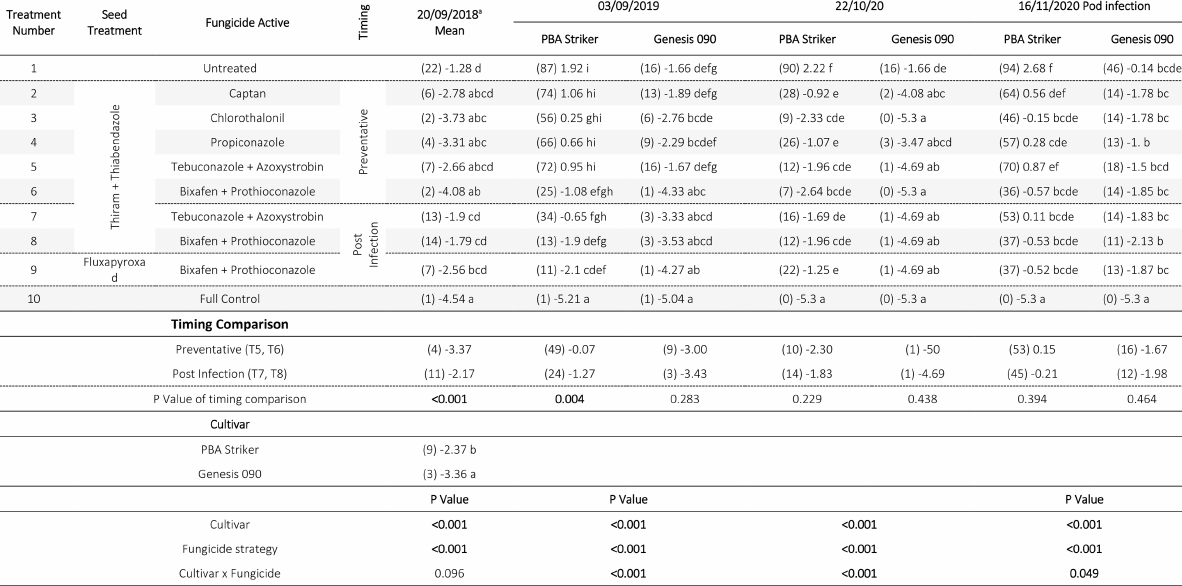
TABLE 6 Chickpea Ascochyta blight disease severity (%) for the significant factors in the fungicide by cultivar experiments at Curyo during 2018 to 2020.